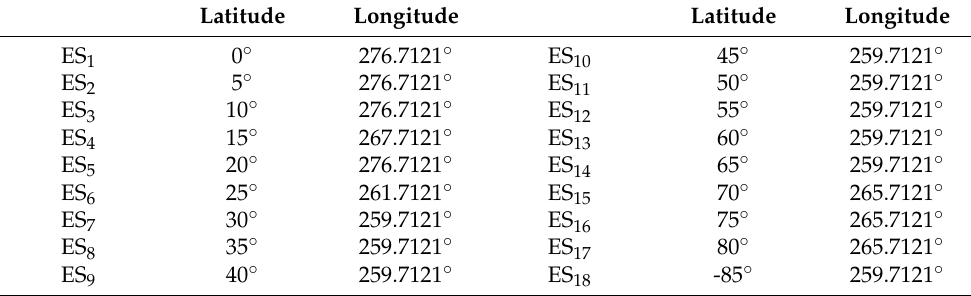
Table 3. ES locations for the performed simulations specified through their latitude, φ , and longitude, λ .